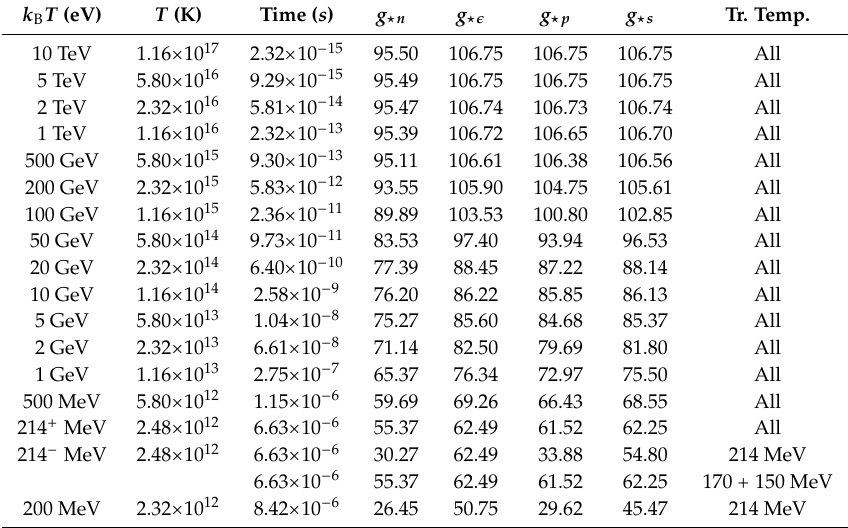
Table A1. Values for time, g ⋆ n , g ⋆ (cid:101) , g ⋆ p , and g ⋆ s from T = 10 TeV to 10 keV. In the region